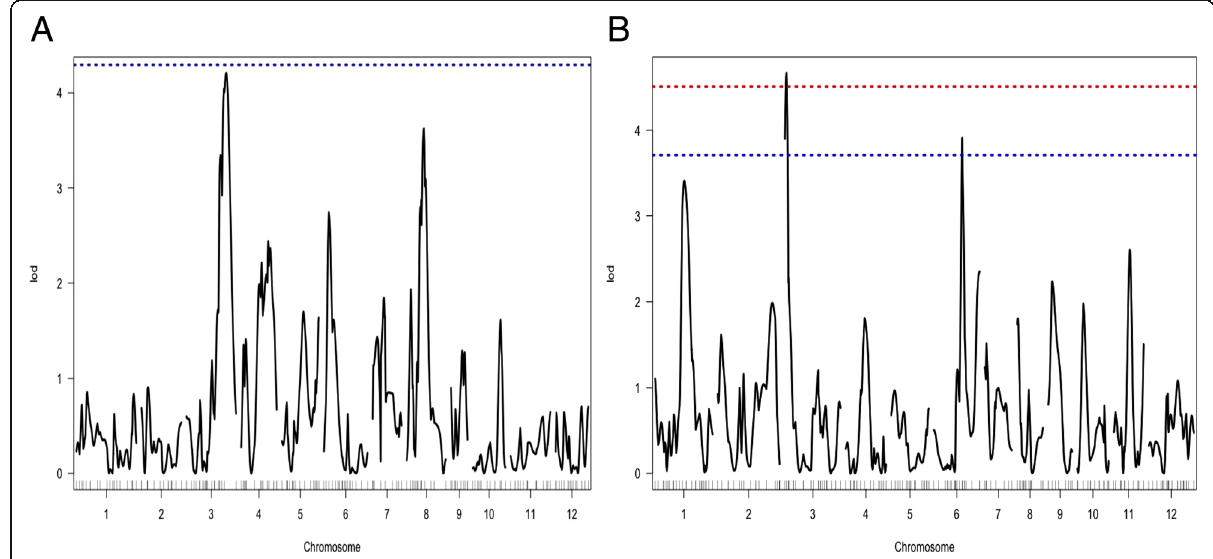
Fig. 5 Whole-genome scan plots by interval mapping for survivability at 21 DAS of the white grain-colored lines of the population Kalarata/NSIC Rc238 ( a ) and for the population Kalarata/NSIC Rc222 ( b ) in the screenhouse. Horizontal lines indicate the significant logarithm of odds threshold at 5% and 1% confidence levels (from the bottom to the top) based on 10,000 permutation